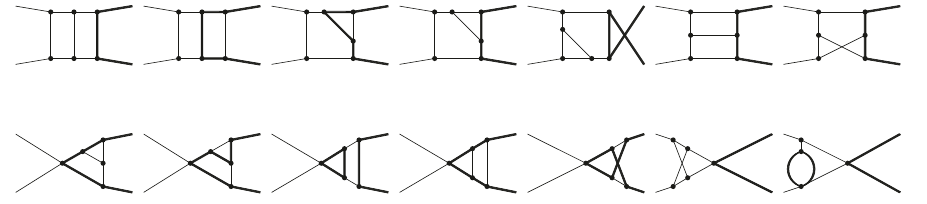
¯ Q . Thin [Thick] lines